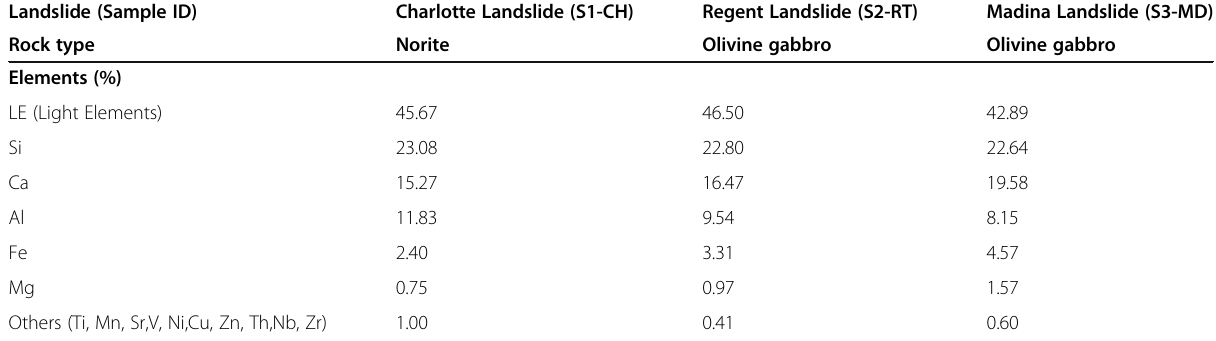
Table 1 Handheld-XRF analysis results of rock samples from the three slides Landslide (Sample ID)